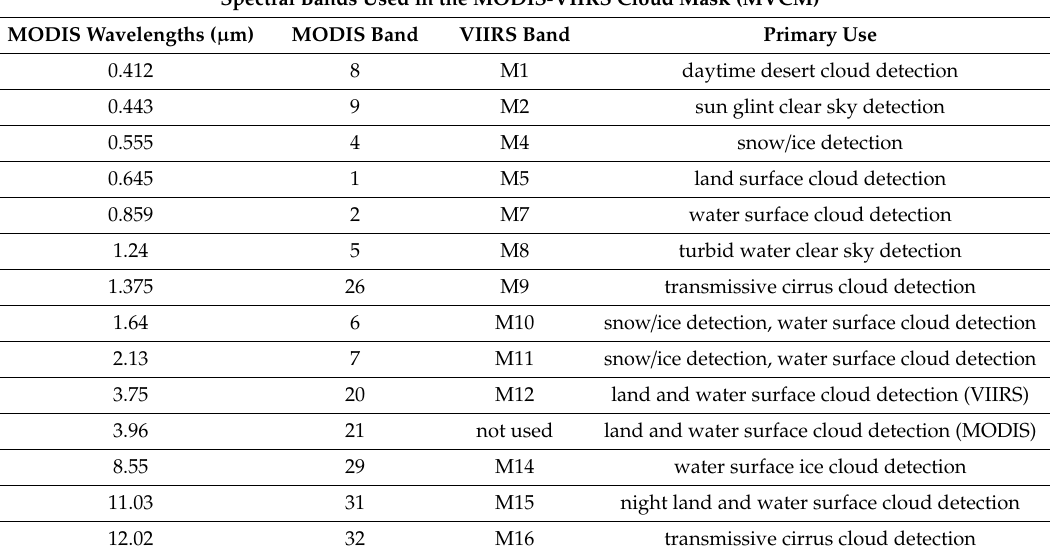
Table 1. Moderate Resolution Imaging Spectroradiometer (MODIS) and Visible Infrared Imaging Radiometer Suite (VIIRS) spectral bands used in the MVCM.